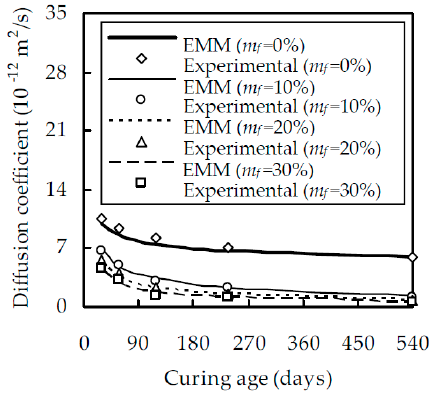
Materials 2019 , 12 , 811 Figure 3. The relationship between D fc and t for fly ash cement paste with w/b of 0.5.